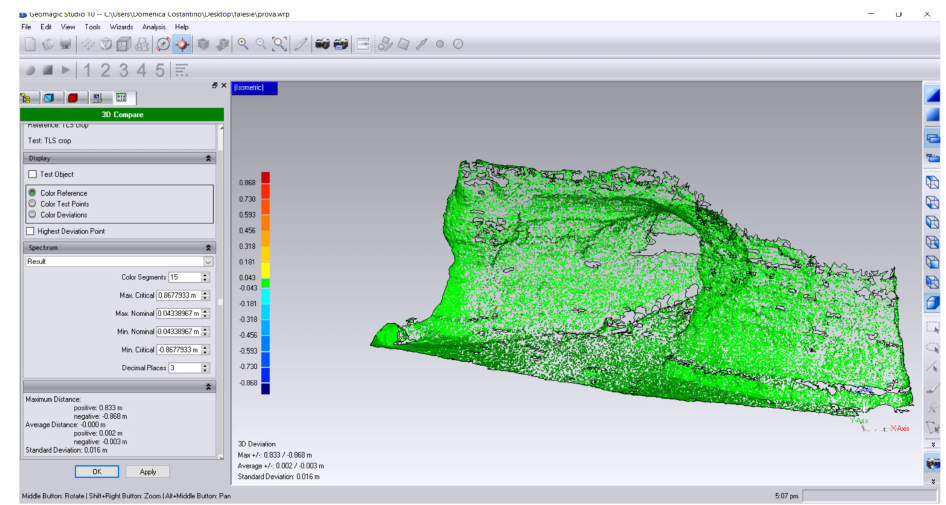
Figure 23. Analysis of the variation of distances in Geomagic software.